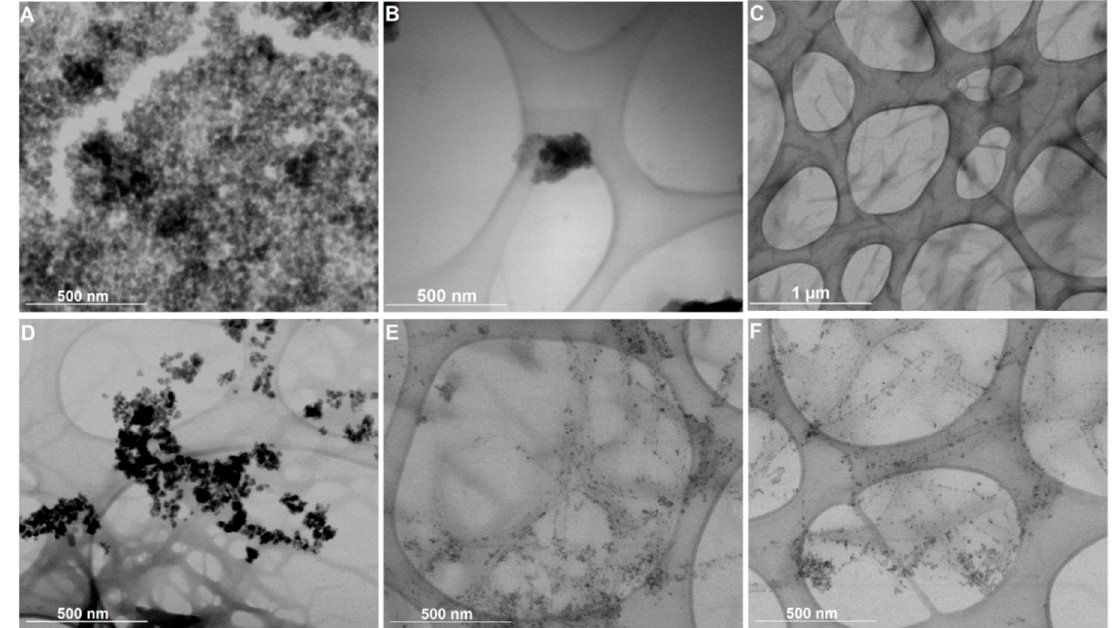
Figure 6. Scanning transmission electron microscopy (STEM) images of ( A ) citrate-stabilized nanoparticles, ( B ) lipid-coated nanoparticles, and ( C ) the hydrogel structure. Magnetogels containing ( D ) citrate-stabilized nanoparticles and ( E , F ) lipid-coated nanoparticles prepared at 0.5 wt% of hydrogelator, 1 wt% of GdL, and 0.05 wt% of nanoparticles.